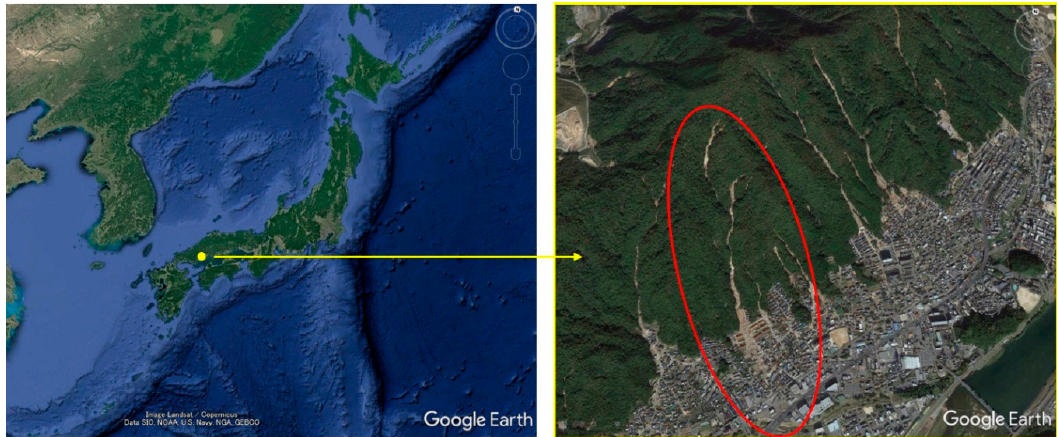
Figure 3. Location of Asaminami, Hiroshima, Japan. The red circle indicates the research area.